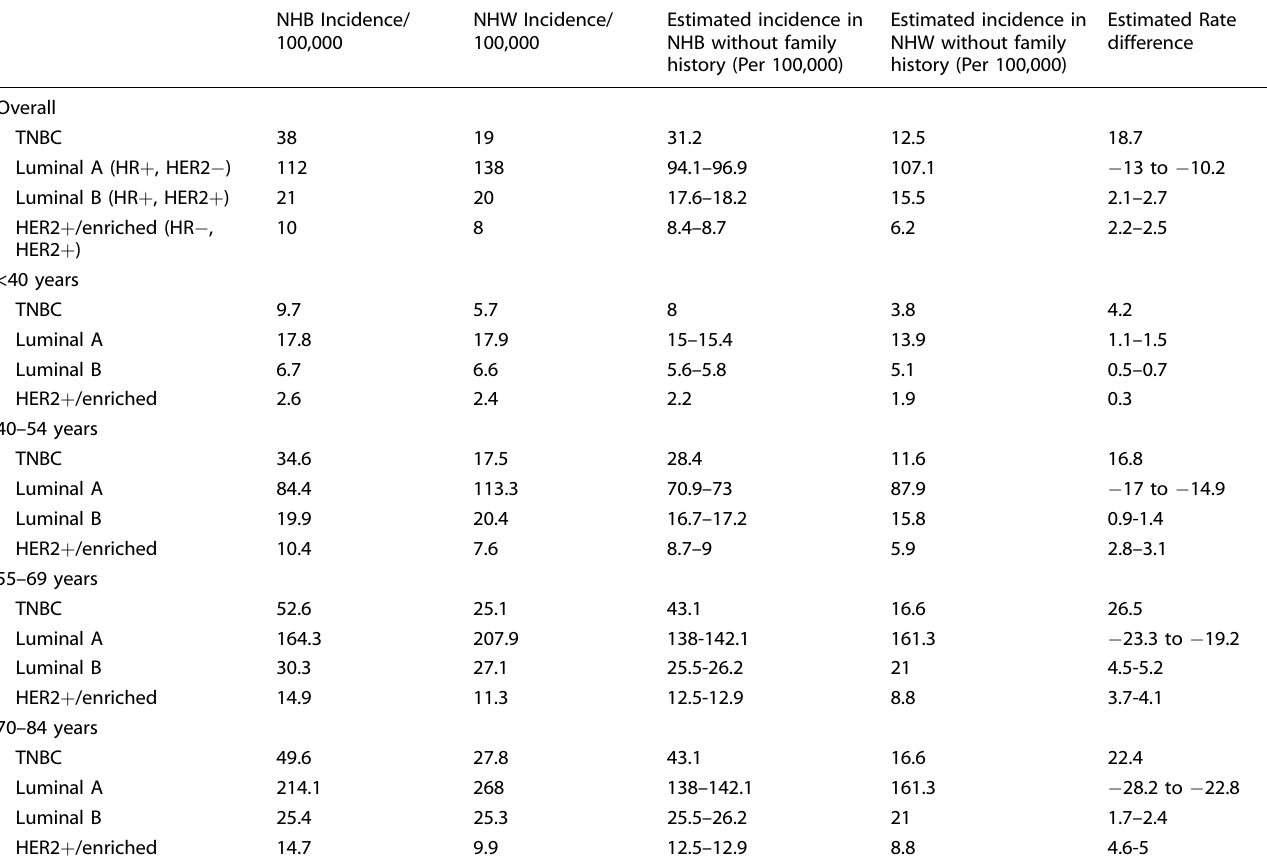
Table 1. Actual incidence rates and estimated rate differences for individuals without a family history between NHB and NHW women by age and breast cancer molecular